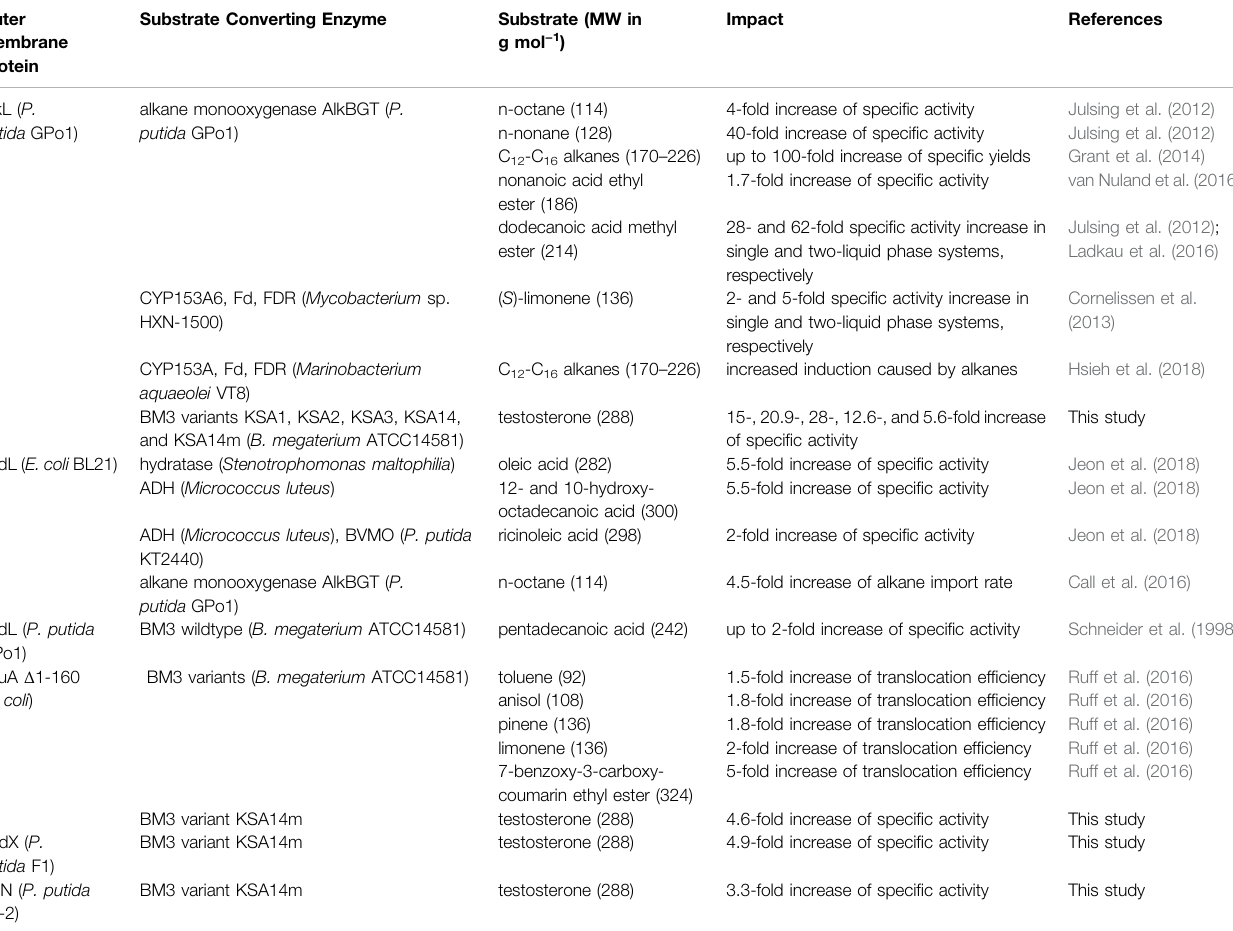
TABLE 1 | Studies reporting enhanced uptake or biotransformation of hydrophobic substrates via heterologous outer membrane